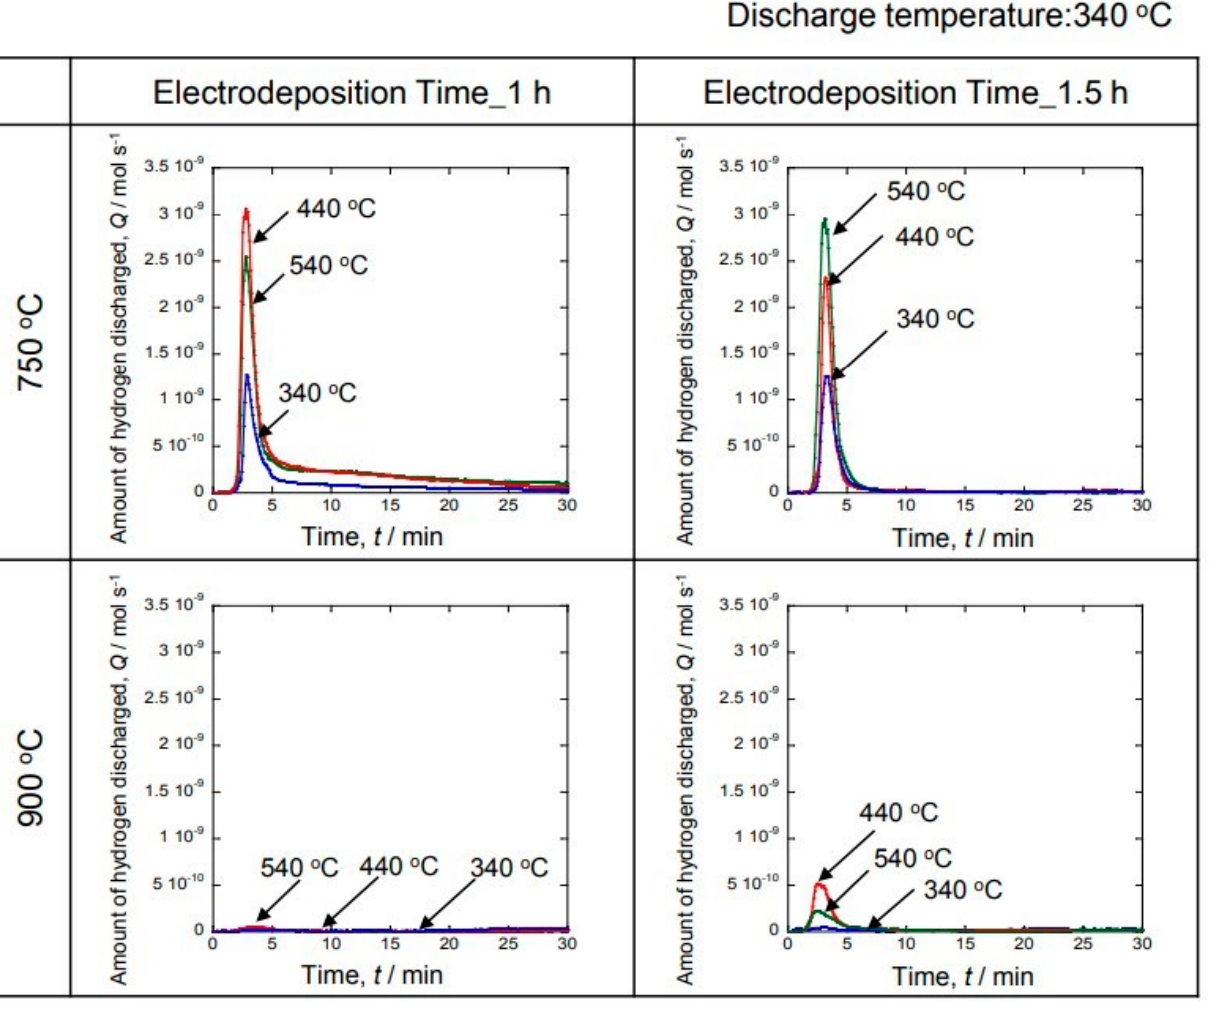
Figure 9. Hydrogen discharge–temperature curves of Ni after La deposition at − 2.25 V in NaCl-KCl- 5.0 mol%LaF 3 melts at 750 °C and 900 °C. (Hydrogen storage temperature: 340 °C, 440 °C and 540 °C.)